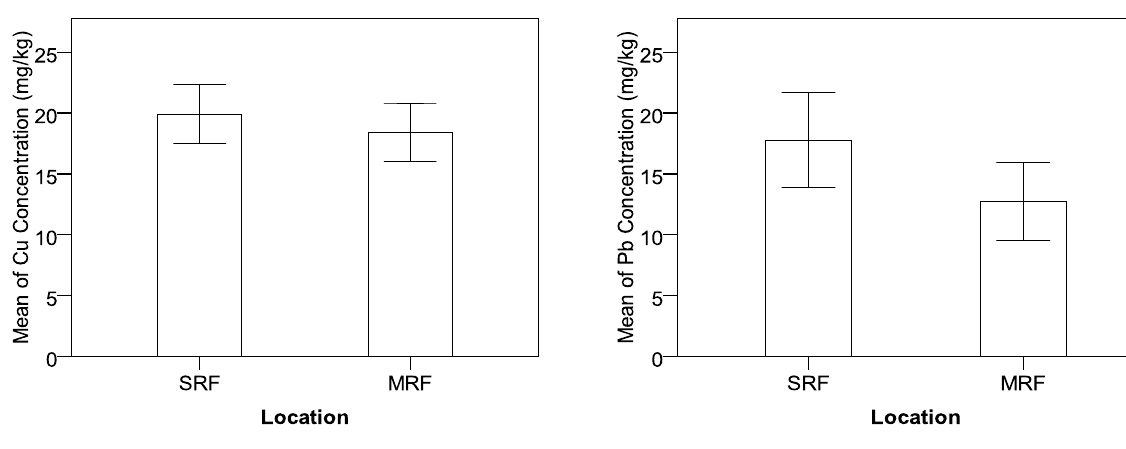
Figure 2. Effects of location on concentrations of Cu and